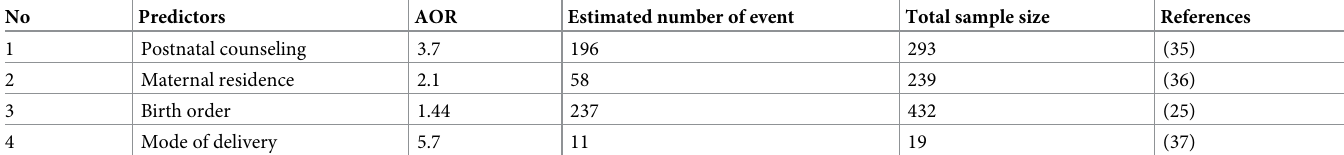
Table 1. Sample size determination for time to initiation of breast-feeding among postnatal mothers within 12 hours of giving birth in Debre Markos Comprehen- sive Specialized Hospital, East Gojjam Zone, North West Ethiopia 2020. No Predictors AOR Estimated number of